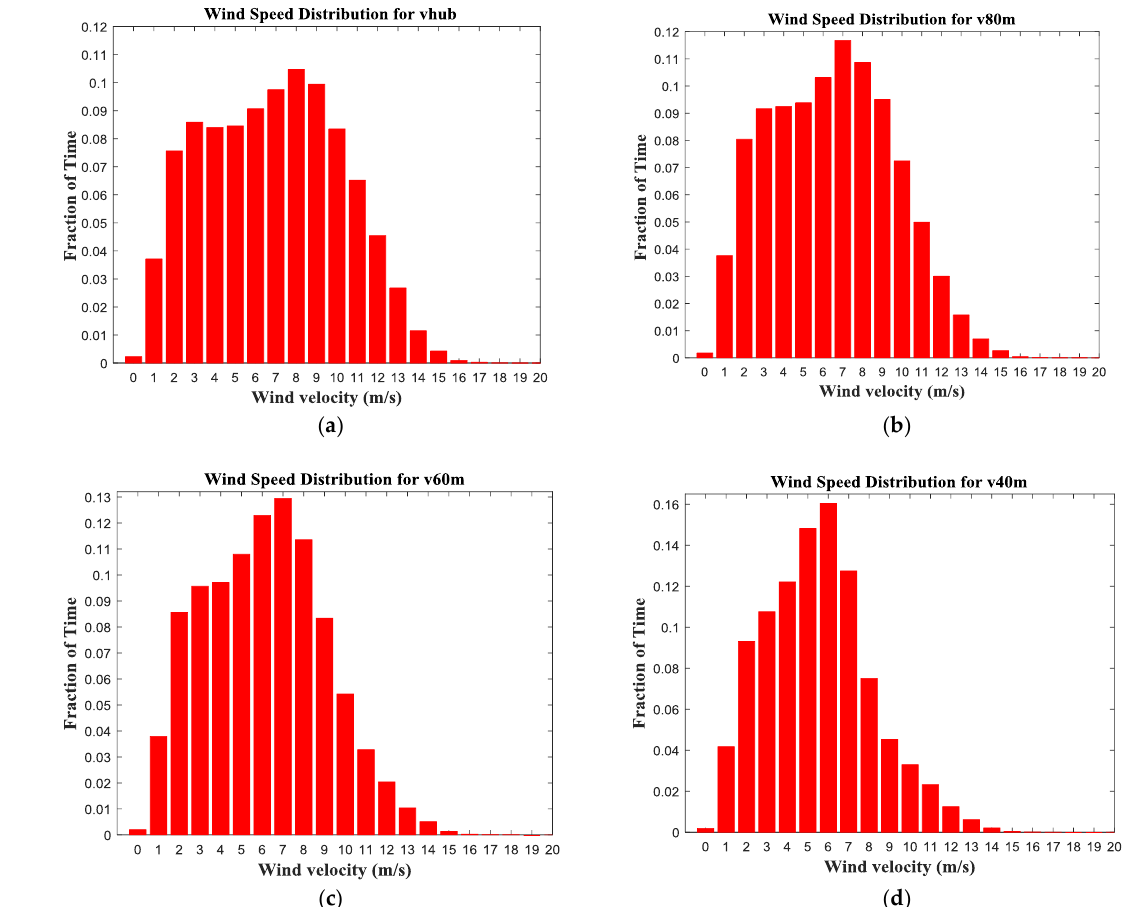
Figure 12. Comparison of placing the five different methods of Weibull probability distributions to measured data for Sanghar site ( a ) at 80 m height ( b ) at 60 m height and ( c ) at 40 m height.